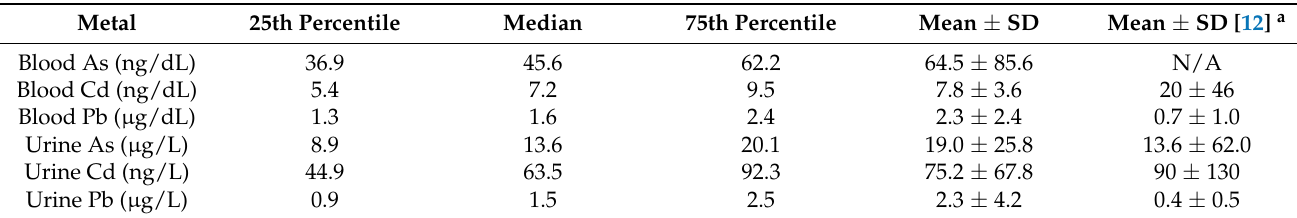
Table 2. Distribution of blood and urine metal concentrations in this sub-cohort, measured at 4–6 years of age (n = 300).